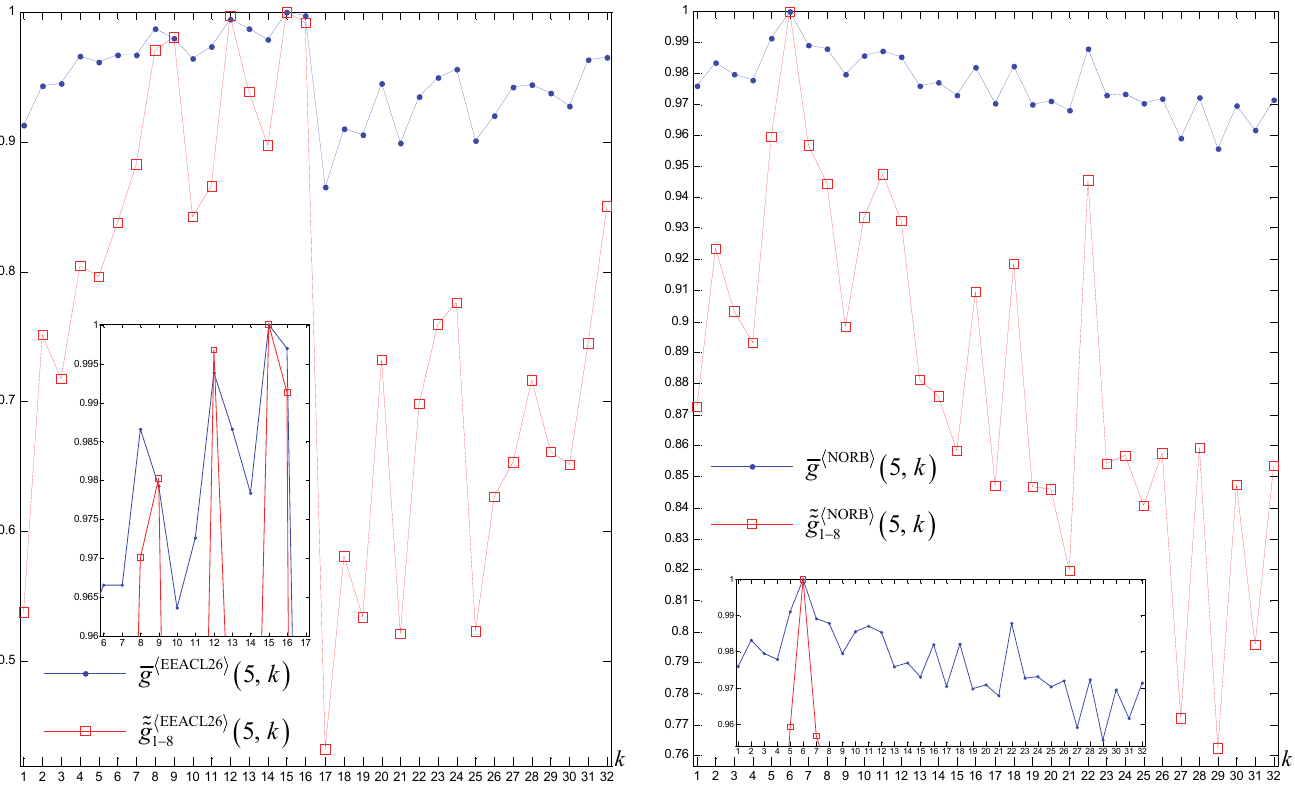
Fig. 15. The normalized averaged RERD (16) and the normalized averaged 5  N on EEACL26. Maxima are less strange final-epoch RERD (17) by ConvL than those ones in Fig. 14, but they are pretty opposite to minima in Fig. 7.